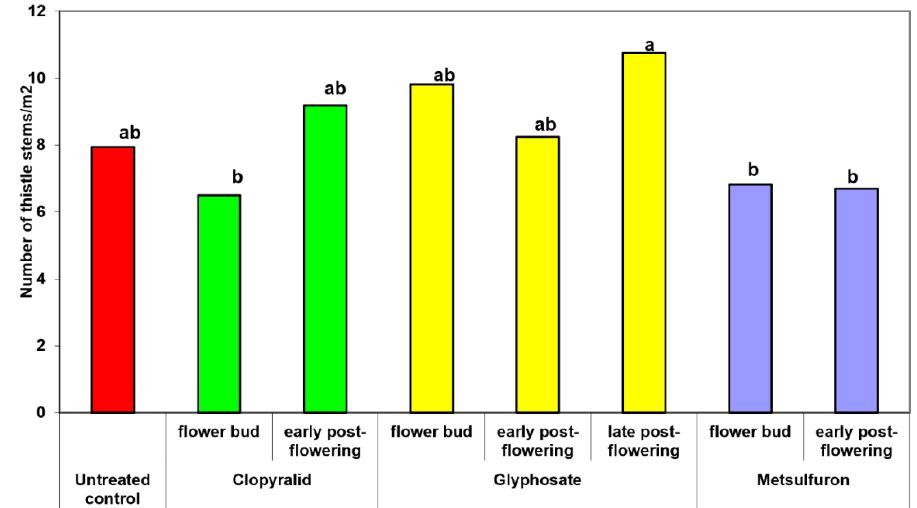
Figure 4. The number of C. arvense stems/m 2 after wiper application of herbicides at different stages. Bars with the same letter are not significantly different (LSD, p < 0.05).